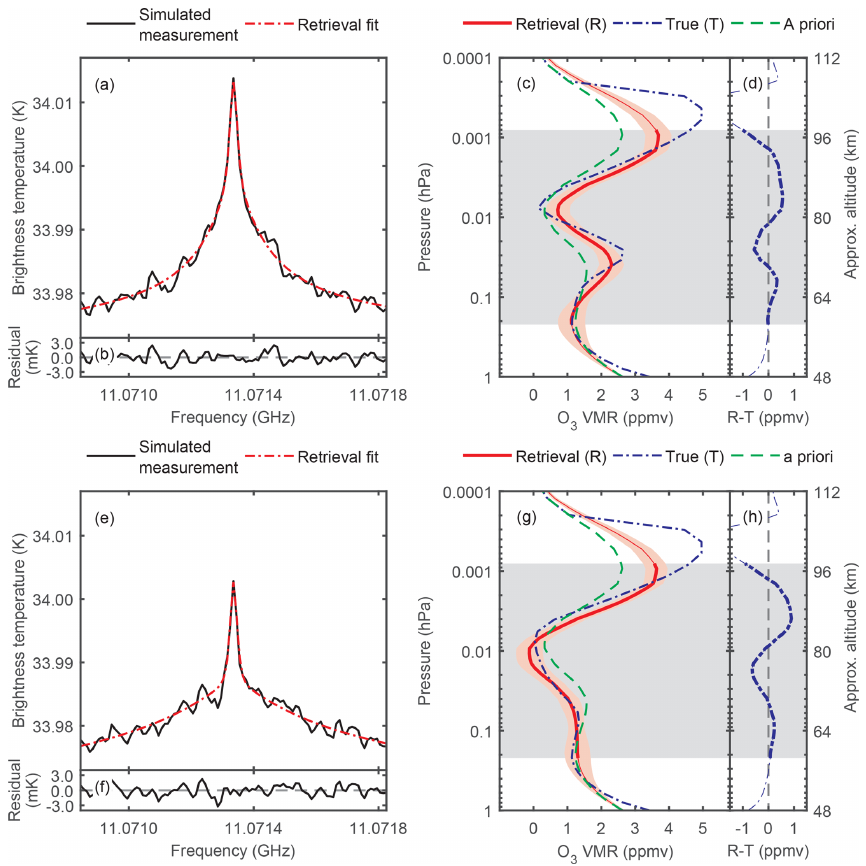
Figure 8. Ozone (O 3 ) retrievals for simulated 6h observations of the O 3 11.072GHz emission line in clear-sky December conditions using a ground-based radiometer at Kilpisjärvi (69 ◦ 03 (cid:48) N, 20 ◦ 48 (cid:48) E), Finland. The forward model clear-sky spectra are calculated using the model O 3 profiles for December 2007 with 1mK baseline noise, 10kHz frequency resolution, and an 82 ◦ zenith angle. Panels (a) – (d) show the results using background (no substorm) O 3 in the simulations, and (e) – (g) show the results for substorm O 3 . The simulated O 3 spectra and retrieval fits are shown in (a) and (e) , and the residual differences are shown in (b) and (f) . The a priori, true, and retrieved O 3 volume mixing ratio profiles, and the differences between the retrieved and true profiles, are shown in (c) – (d) and (g) – (h) for the background and substorm cases